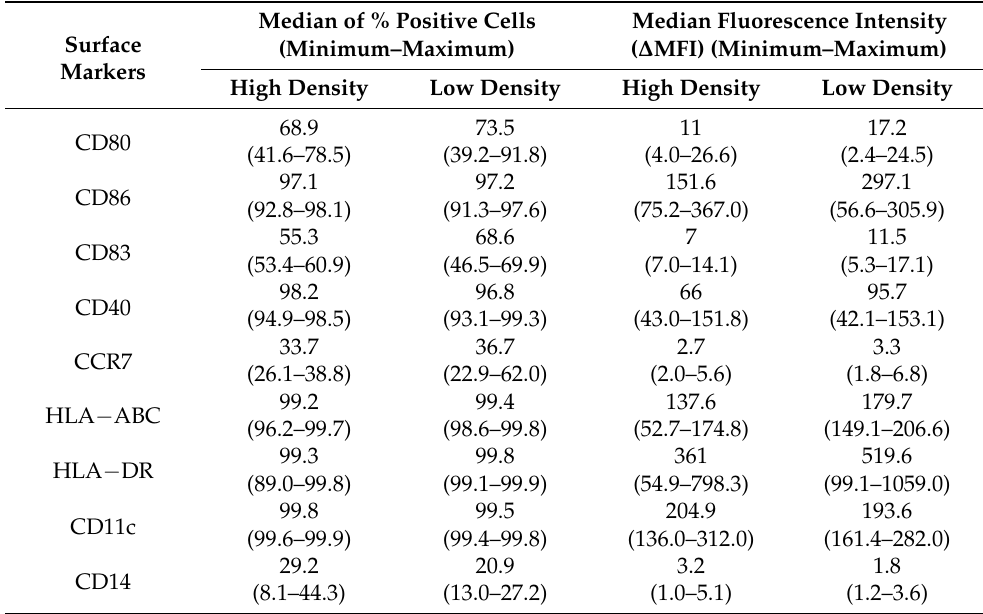
Table 1. Comparison of the phenotype of DCs after maturation at high and low